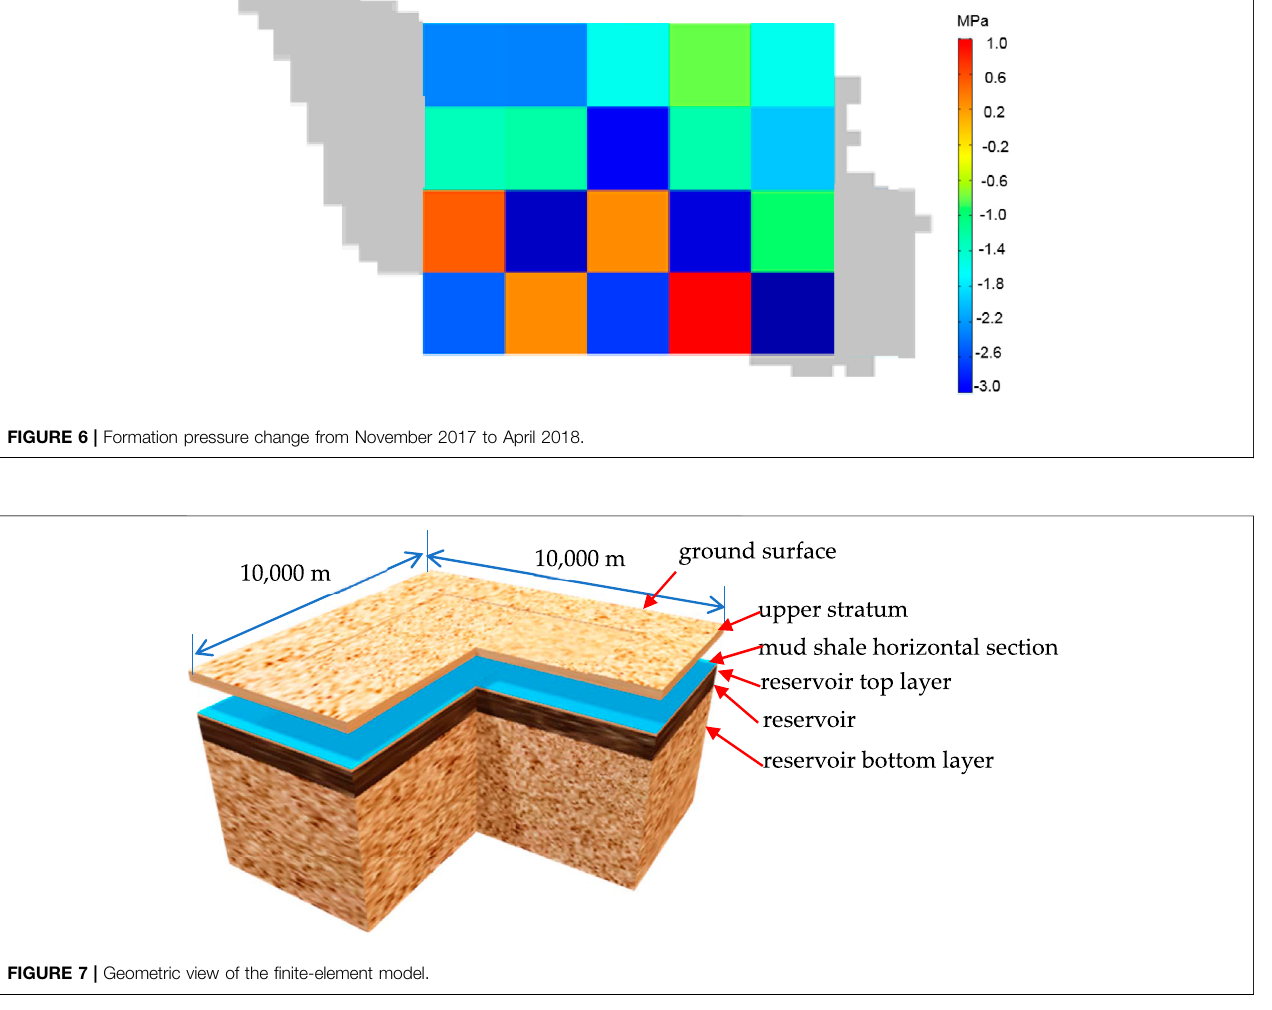
TABLE 1 | Conditions and mechanical parameters of the strata in the geomechanical model.